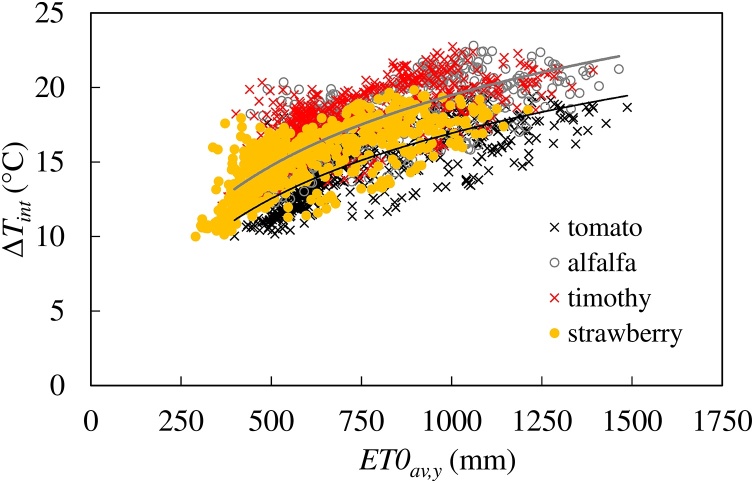
Reduction of roof temperature versus evapotranspiration. Comparisons among different crops.